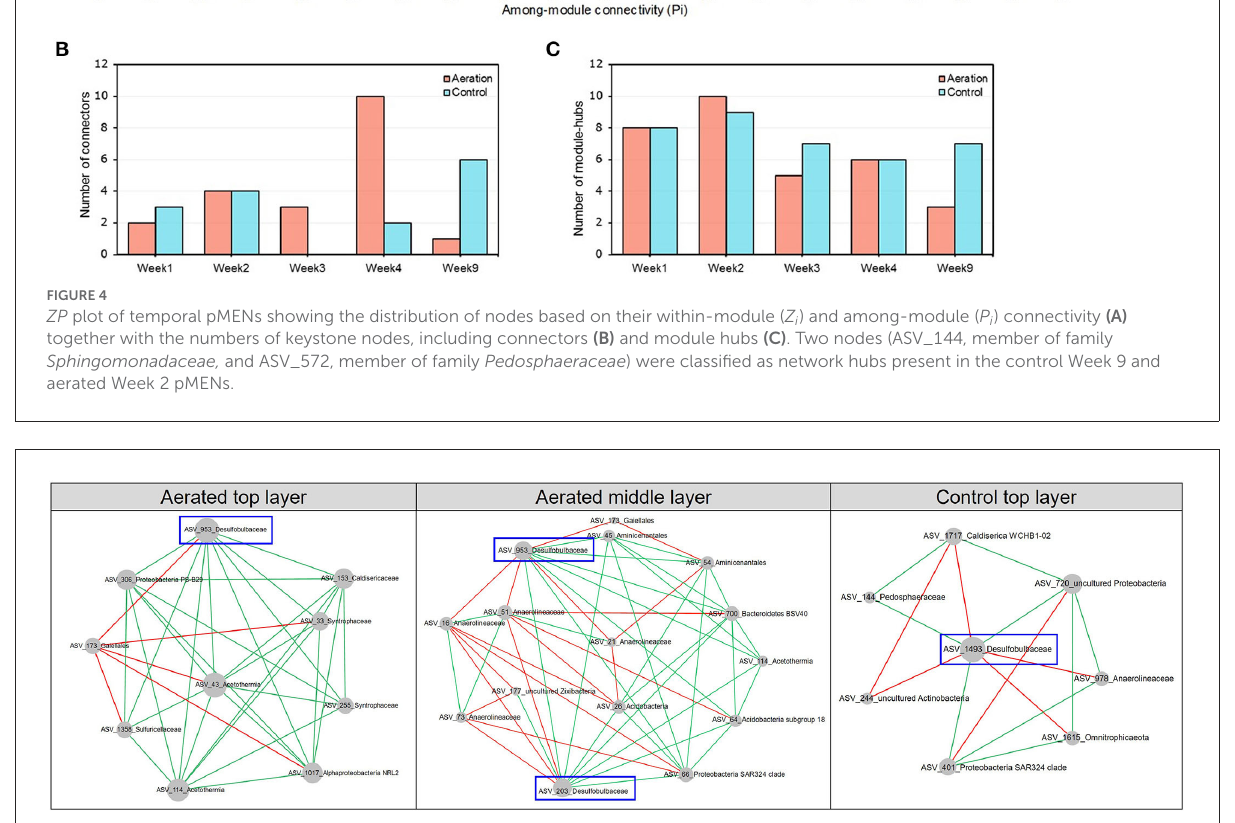
FIGURE5 Subnetworks revealing interactions among nodes of Desulfobulbaceae and direct-linking nodes of other families in the aerated top, control top, and aerated middle layers. Node size was proportional to node degree in subnetworks. A link represented a significant Spearman’s Rho rank correlation between two nodes, green for positive and red for negative